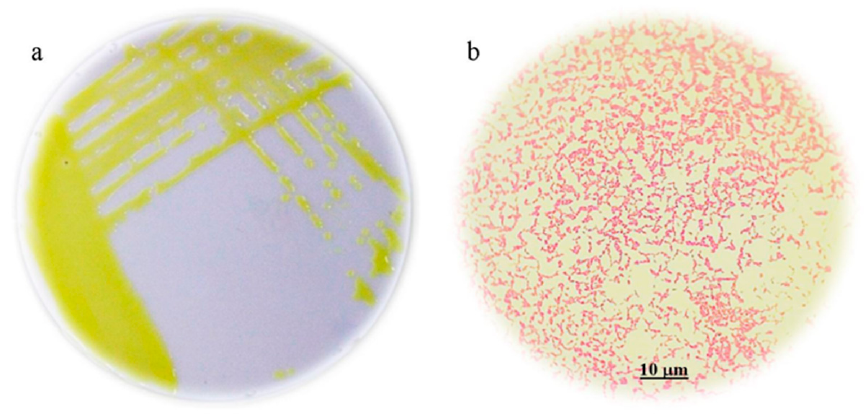
Figure 1. Characterization of the Xcf1-APJR strain: ( a ) Morphology of yellow colonies, with a smooth, luminous and butyrous appearance in medium culture YDC with 10 days of growth; ( b ) negative gram bacilli (60×).